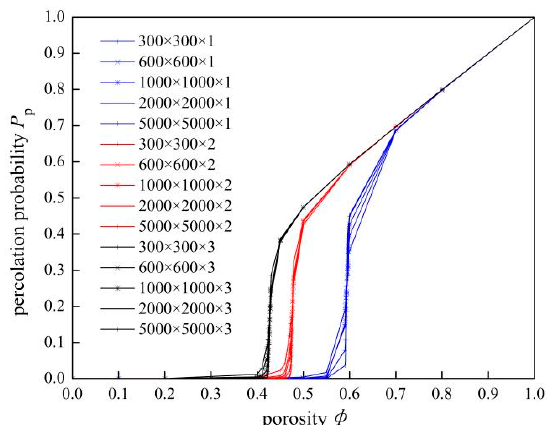
Figure A3. The percolation threshold of the sealing interface under different layers of grids.